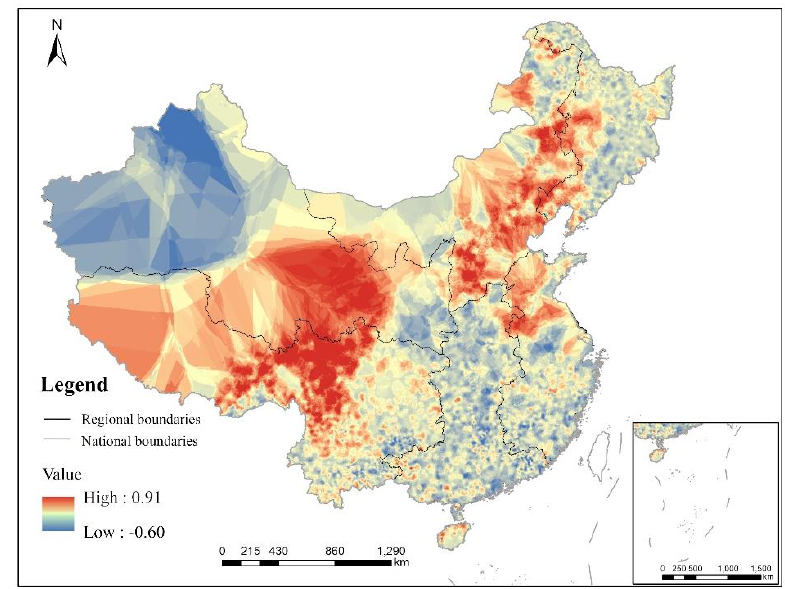
Figure 7. Map of the likelihood of forest fire occurrence obtained from the whole study area model minus that obtained from the regional model.